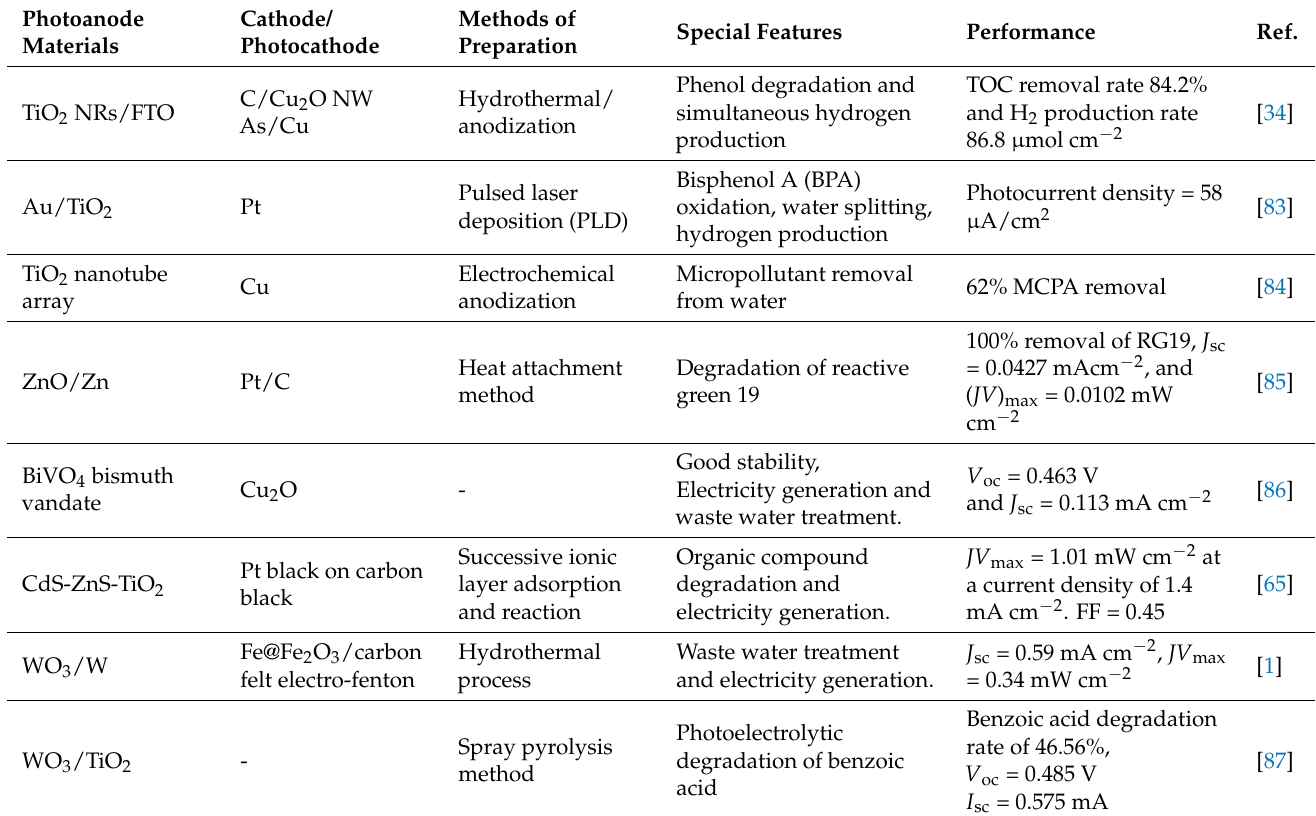
Table 1. Electrodes and their methods of preparation with major features of